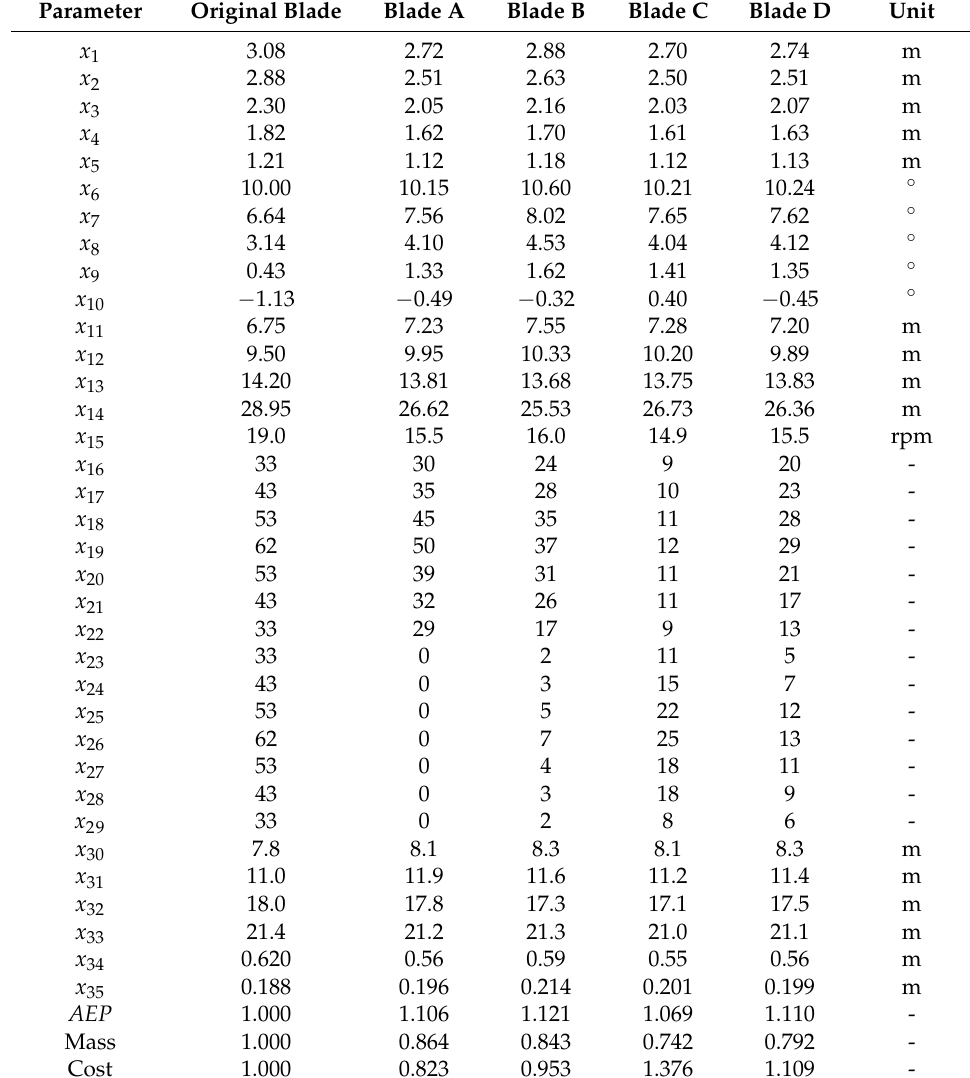
Table 5. Values of the design variables and